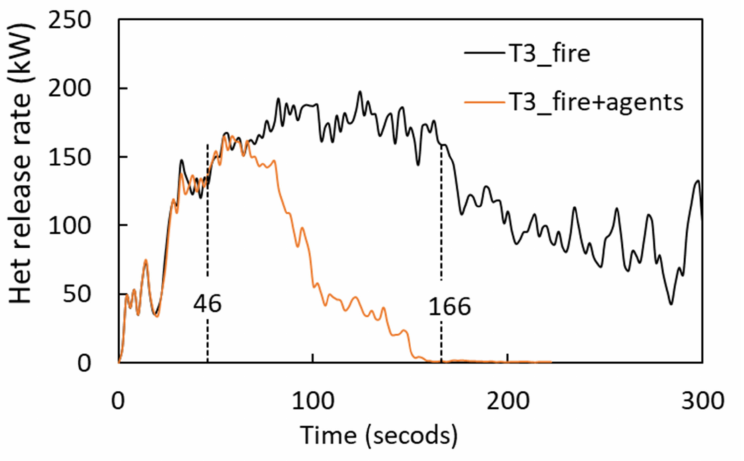
Figure 11. Heat release rate for simulation series